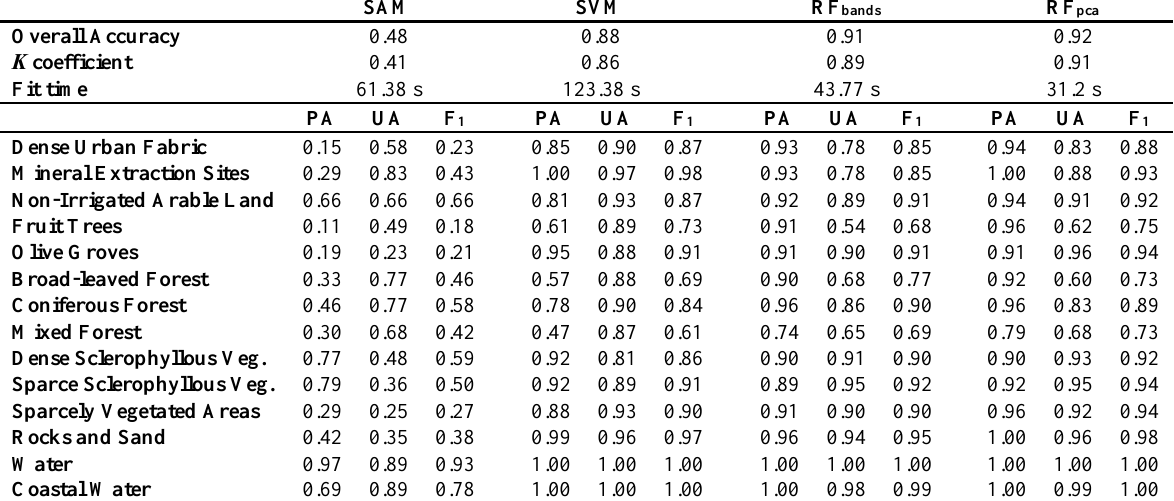
Table 1 – Evaluation metrics used for evaluation of the classification approaches, Overall Accuracy (OA), Kappa index ( K ),